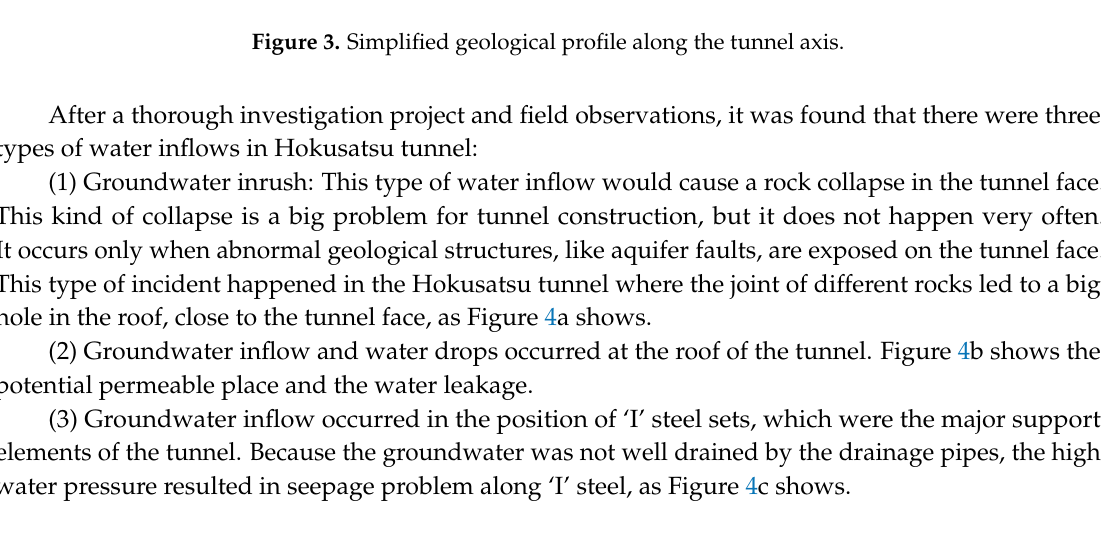
Figure 3. Simplified geological profile along the tunnel axis.